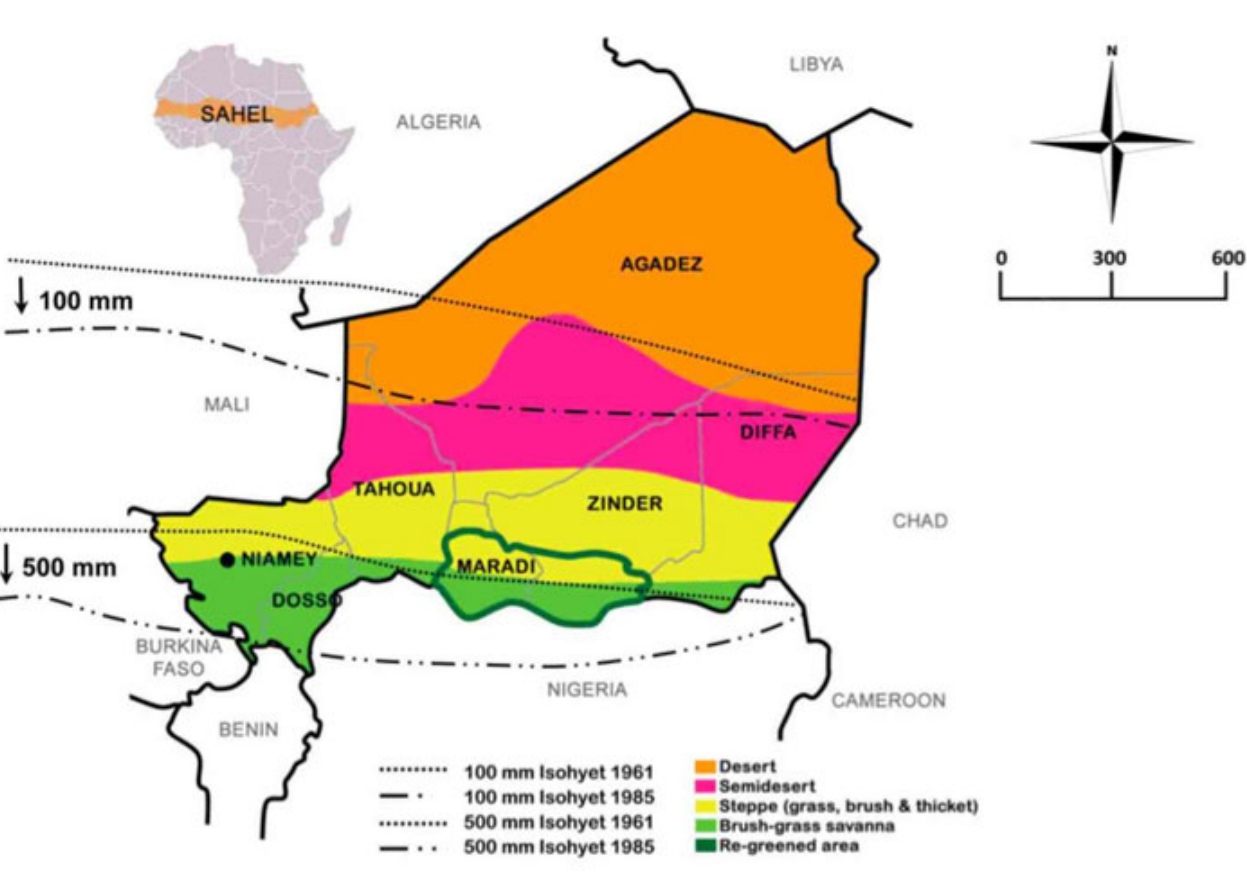
Fig. 1 . Cities, regional boundaries, and vegetation zones of Niger, West Africa. The green outline shows an estimate of the area regreened in Maradi and Zinder regions of south–central Niger (source: USGS), and the hatched lines show the southward shift of the 100-mm and 500-mm rainfall isohyets during the drying trend from 1970 to the late 1980s (Koechlin 1997:17). The boundaries between vegetation zones are more gradual shifts in species distributions than sharp, distinct